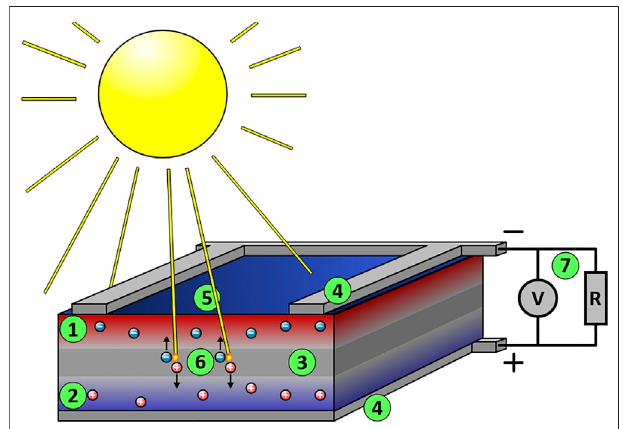
FIGURE 2 | Schematic representation of a silicon monocrystalline solar cell. The circles present the excited electrons and holes. They are then extracted to the conductance band of an n-type conductor and from there passed around a circuit and eventually returned to the valence band of the p-type conductor. (1) The upper silicon layer is interspersed with electron donors (e.g., phosphorus atoms), negatively doped. There are too many electrons here (n-layer). (2) The lower silicon layer is interspersed with electron acceptors (e.g., boron atoms), positively doped. Here, there are too few electrons, i.e., too many defects or holes (p-layer). (3) In the border region of the two layers, the excess electrons of the electron donors bind loosely to the vacancies ofthe electron acceptors (they occupy the vacancies in the valence band) and form a neutral zone (p-n junction). (4) Since there is now a lack of electrons at the top and a lack of vacancies at the bottom, a constantly present electric fi eld forms between the upper and lower contact surfaces. (5) Photons (light quanta, “ sun rays ” ) enter the transition layer. (6) Photons with suf fi cient energy transfer their energy to the loosely bound electrons in the valencebandoftheelectronacceptorsintheneutralzone.Thisreleasesthese electrons from their bond and lifts them into the conduction band as free charge carriers. Many of these free charge carriers (electron-hole pairs) disappear again after a short time through recombination. Some charge carriers drift — moved by the electric fi eld — to the contacts in the similarly doped zones (see above); i.e., the electrons are separated from the holes, the electrons drift upwards, and the holes downwards. A voltage and a usable current are created as long as further photons continuously generate free charge carriers. (7) The “ electron ” current fl ows through the “ outer circuit ” to the lower contact surface of the cell and recombines there with the holes left behind (Paetzold,